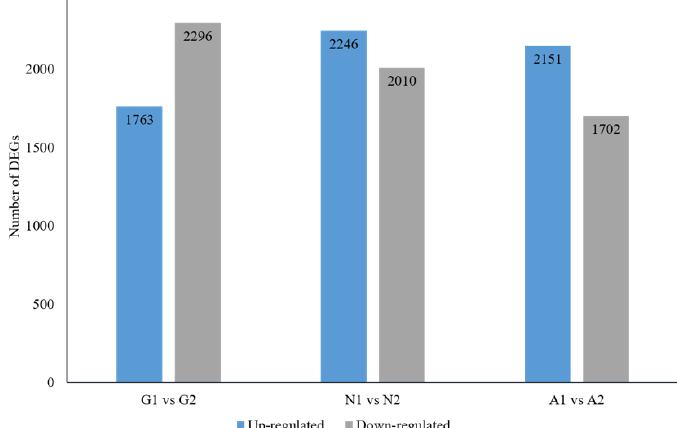
Figure 2. Comparison of the number of differentially expressed genes between CLso-infected and uninfected midguts (G1 vs. G2, respectively), nymphs (N1 vs. N2) and adults (A1 vs. A2).